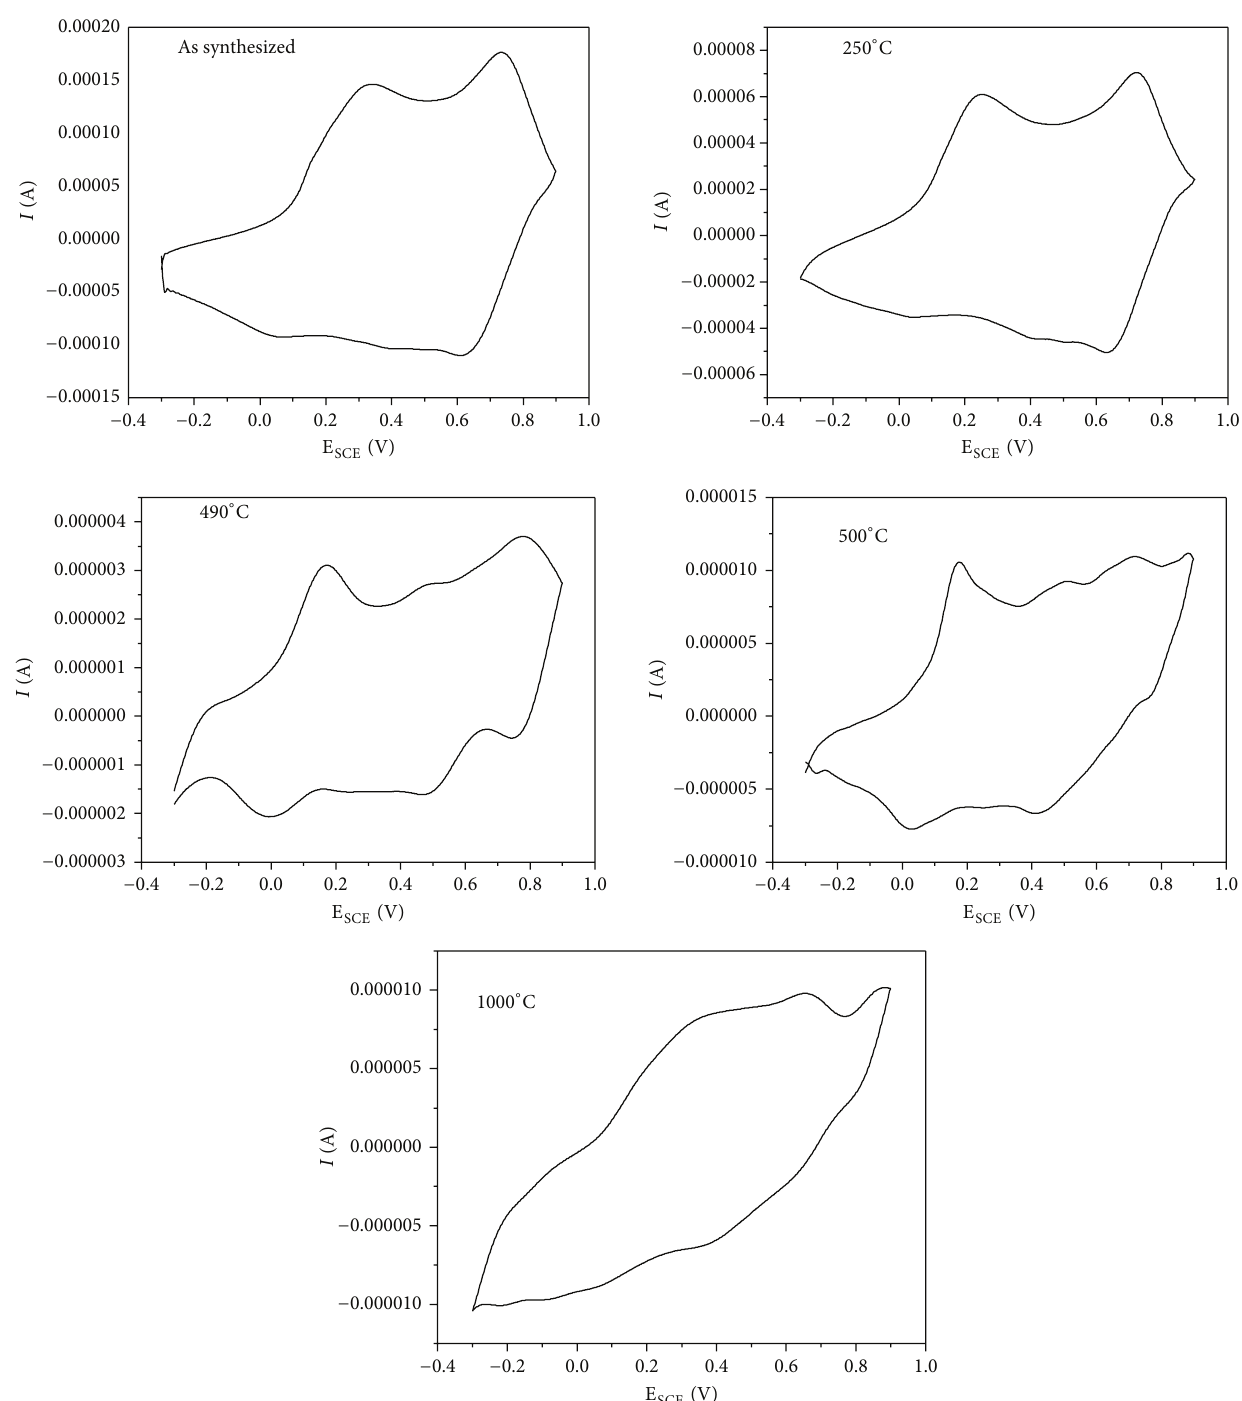
Figure 2: CVs of emeraldine salt on a gold disc electrode (versus SCE) in 0.5 M H 2 SO 4 . The sample is treated at various temperatures as